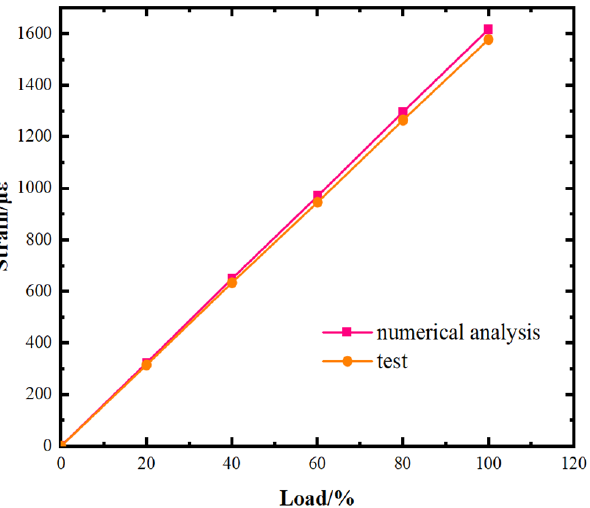
Figure 8. The strain curve under the test load.